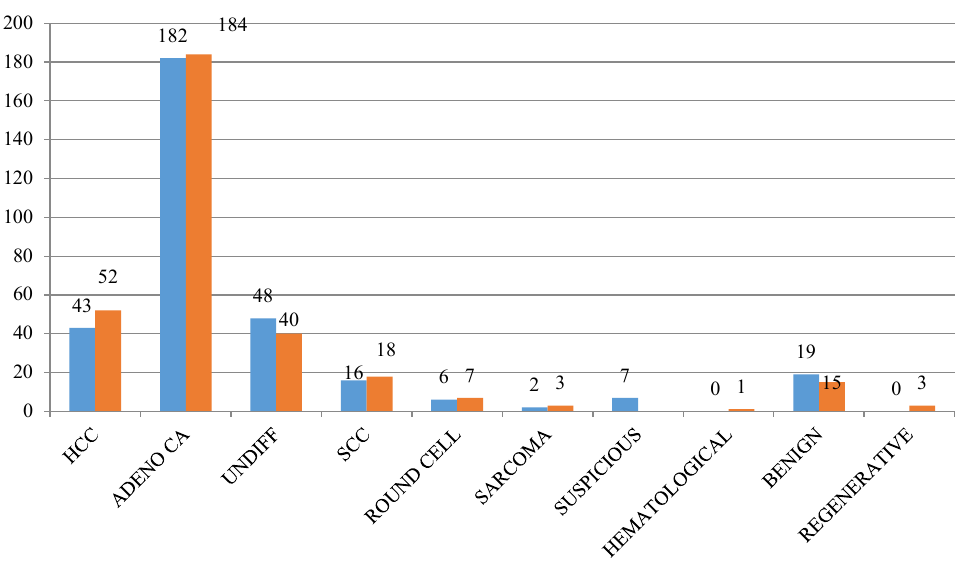
Fig. 4. Comparison of the cell block results with the biopsy